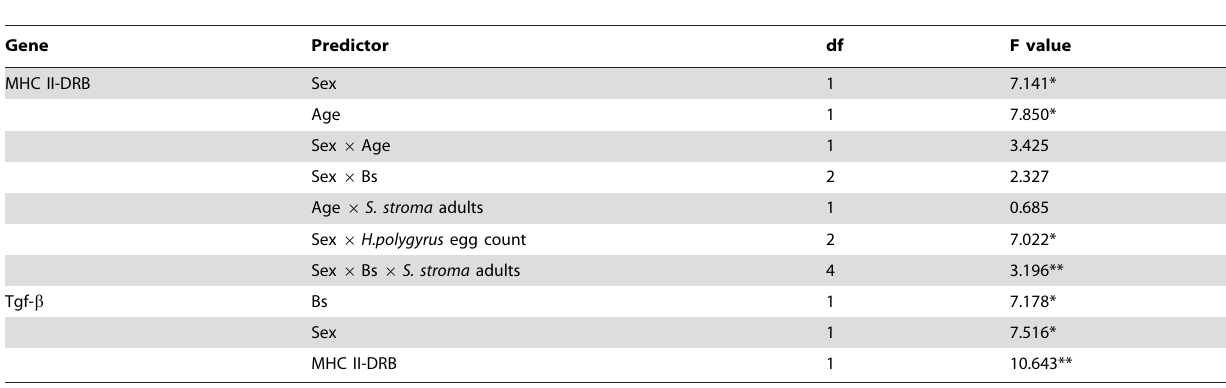
Table 3. Linear models explaining the effects of helminth infection intensity on studied genes expression.